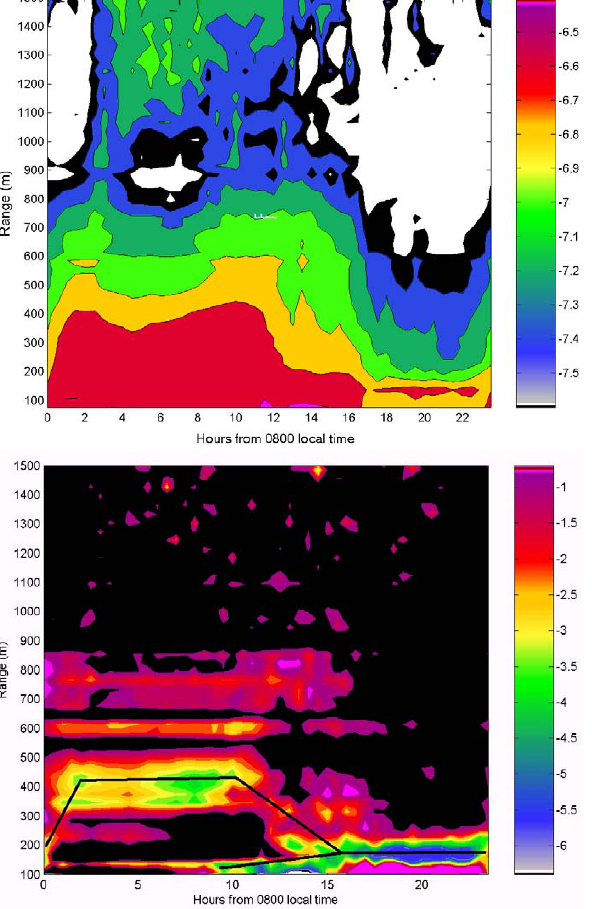
Fig. 6. Upper panel: Contour plot of the averaged daily backscat- ter versus height (evaluated for the entire 10 week data collection period) as derived from the subset of data with SNR values in the range − 5dB to − 17dB. The contours are at 2dB intervals. The horizontal axis is 24h starting at 08:00. The colour bar scale is log10 backscatter coefficient (m − 1 sr − 1 ). Lower panel: Same data set re-plotted in terms of the relative gradient of the backscatter ver- sus range. The black lines indicate the approximate positions of the regions of maximum gradient through the day. Figure (8) A contour plot of the average standard deviation of the vertical velocity evaluated from the entire 10 week data collection period. All SNR values >17dB are included. The contours are every 0.1 ms -1 28